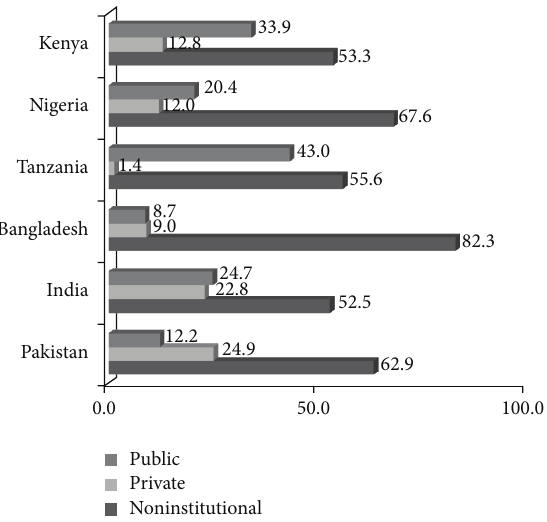
Figure 1: Percentage distribution of the place of delivery by country.